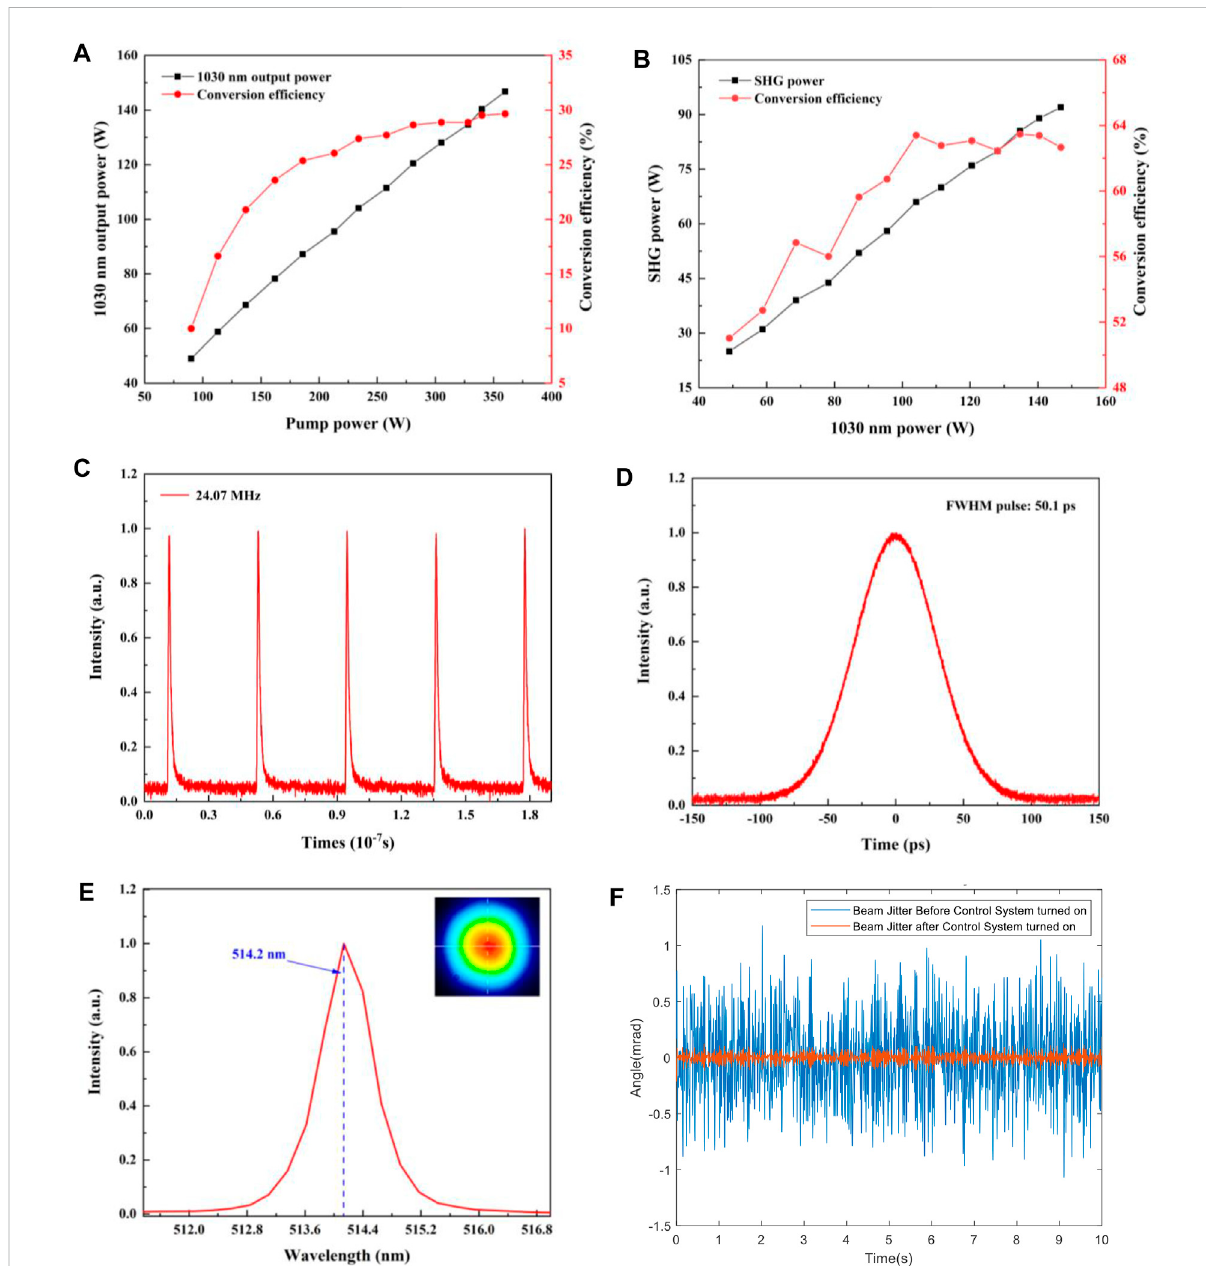
FIGURE 3 Compilation of output characteristics of the green laser. (A) 1,030 nm output power plotted against the pump power; (B) output SHG power at 512 nm plotted against the 1,030 nm input power; (C) Normalized pulse characteristics of the output with a close-up shown inset; (D) temporal characteristicofasingleoutputpulsewithanautocorrelationtrace; (E) normalizedwavelengthspectrumoftheampli fi edlaseroutput; (F) Beamjitter before and after control system turned